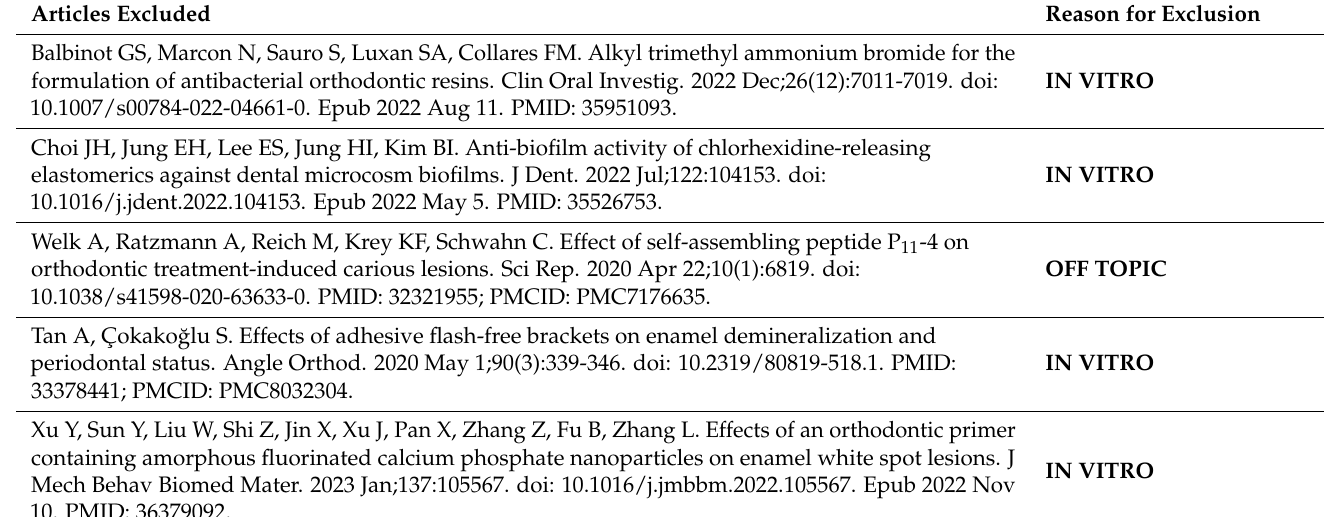
Table A1. Articles Excluded after